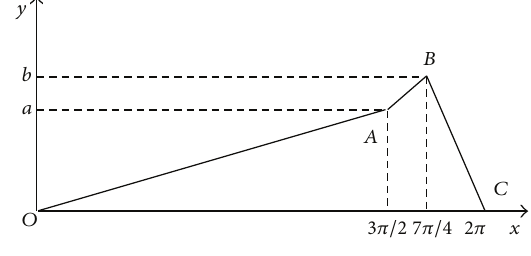
Figure 10: The stroke of the main